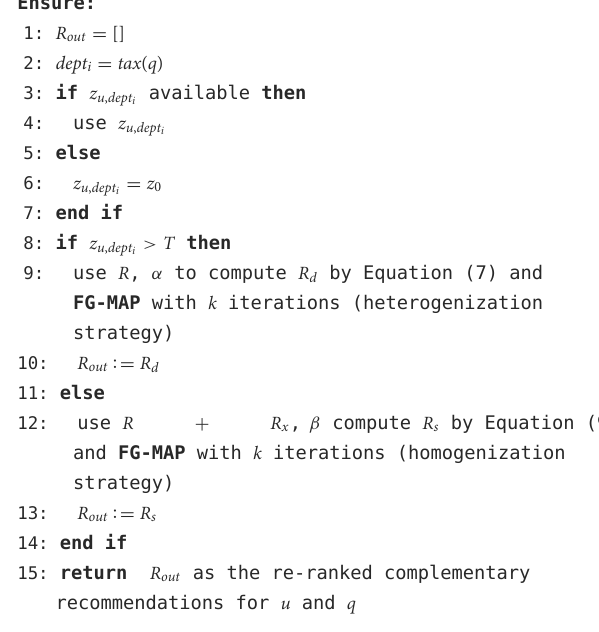
Algorithm 1. Dynamic re-ranking of complementary recommendation with user